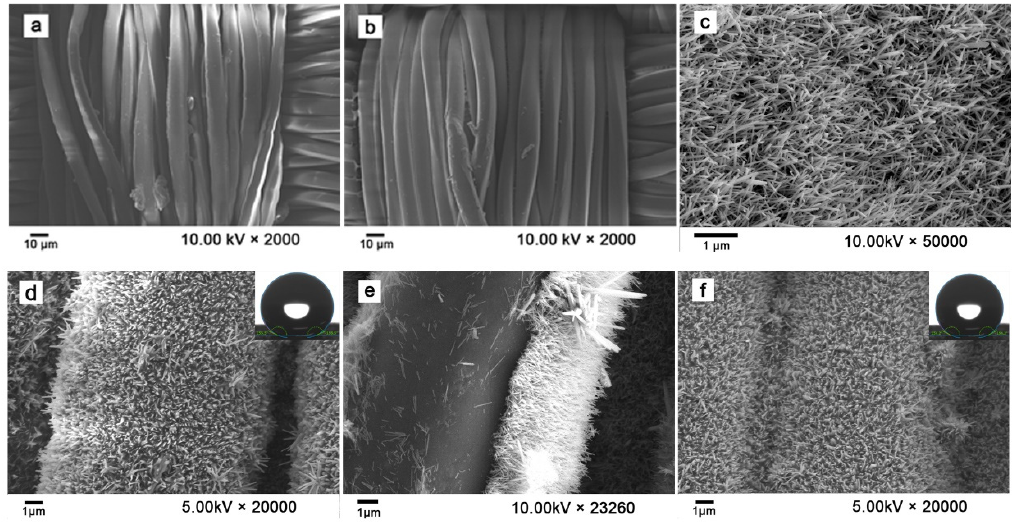
Figure 2. SEM images of pristine PET fabric ( a ), PET- g -PMAPS ( b ), ZnO-NWs@PET ( c , e ), and PDMS@ZnO-NWs@PET ( d , f ), displayed on a di ff erent scales.